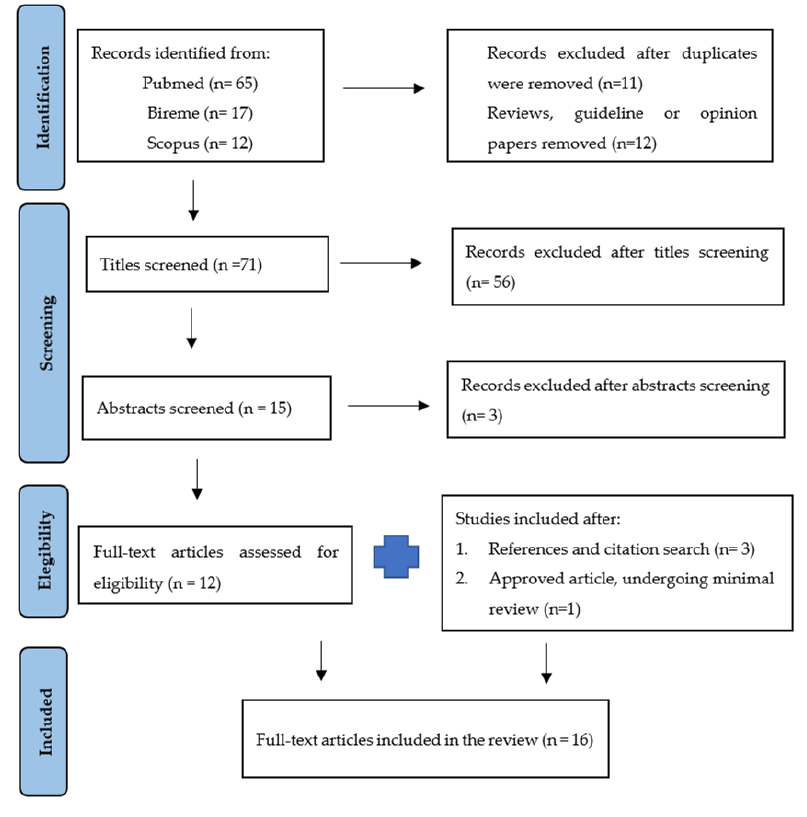
Figure 1. PRISMA Diagram. Table 1. Inclusion and Exclusion